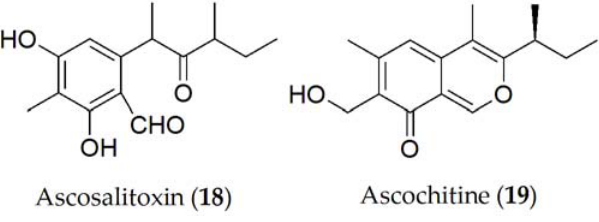
Figure 3. Phytotoxins isolated from Ascochyta pisi .